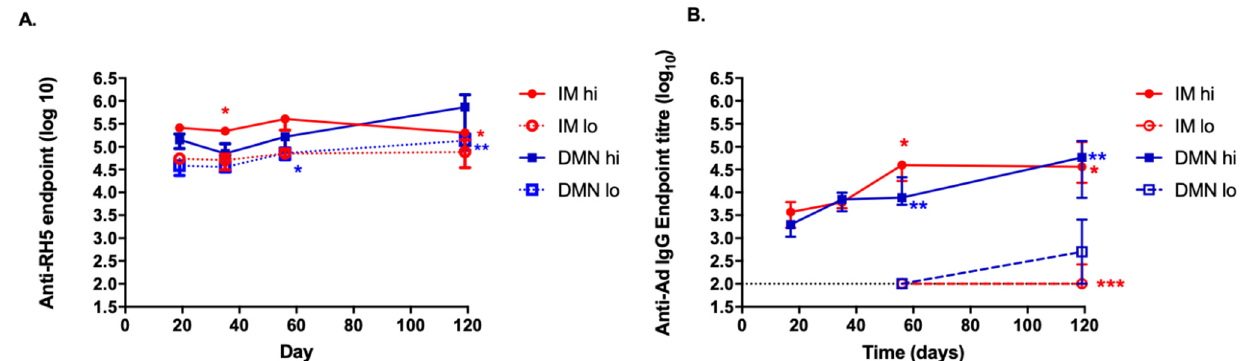
Figure 6. Effect of vaccine dose and route on the kinetics of IgG antibodies to PfRH5 antigen and to the adenovirus vector. Female Balb/c mice were immunized on day 0 with AdHu5–PfRH5 by the IM route or using DMN patches. Mice were administered the standard 1 × 10 8 ifu by IM injection or with a DMN patch (“IM hi” or “DMN hi”). Alternatively, mice were administered a low dose of 5 × 10 4 ifu by IM injection or DMN patch (“IM lo” or “DMN lo”). IgG responses to ( A ) the encoded antigen PfRH5 and ( B ) to the AdHu5 vector over time (n = 10 on day 17, n = 7 on days 35, 56, n = 4 on d119). Symbols represent median, bars represent interquartile range. For IgG responses to PfRH5, no significant differences in titres were observed over time for IM-lo or DMN-hi; for IM-hi; * p < 0.05 for day 17 compared to day 35 and day 119; * p < 0.05 for day 56 compared to day 119; for DMN-lo, * p < 0.05; day 17 compared to day 56; * p < 0.05 day 35 compared to day 119, ** p < 0.01; day 17 compared to day 119, by one-way ANOVA, Kruskal–Wallis test with Dunn’s multiple comparison. For IgG responses to AdHu5, in IM-hi; * p < 0.05 for day 17 compared to day 56 and day 119; in DMN-hi ** p < 0.01 for day 17 compared to day 56 and d119; in IM-lo; *** p < 0.001 compared to all other timepoints; no significant differences in titre were observed over time for DMN-lo, by one-way ANOVA, Kruskal–Wallis test with Dunn’s multiple comparison.